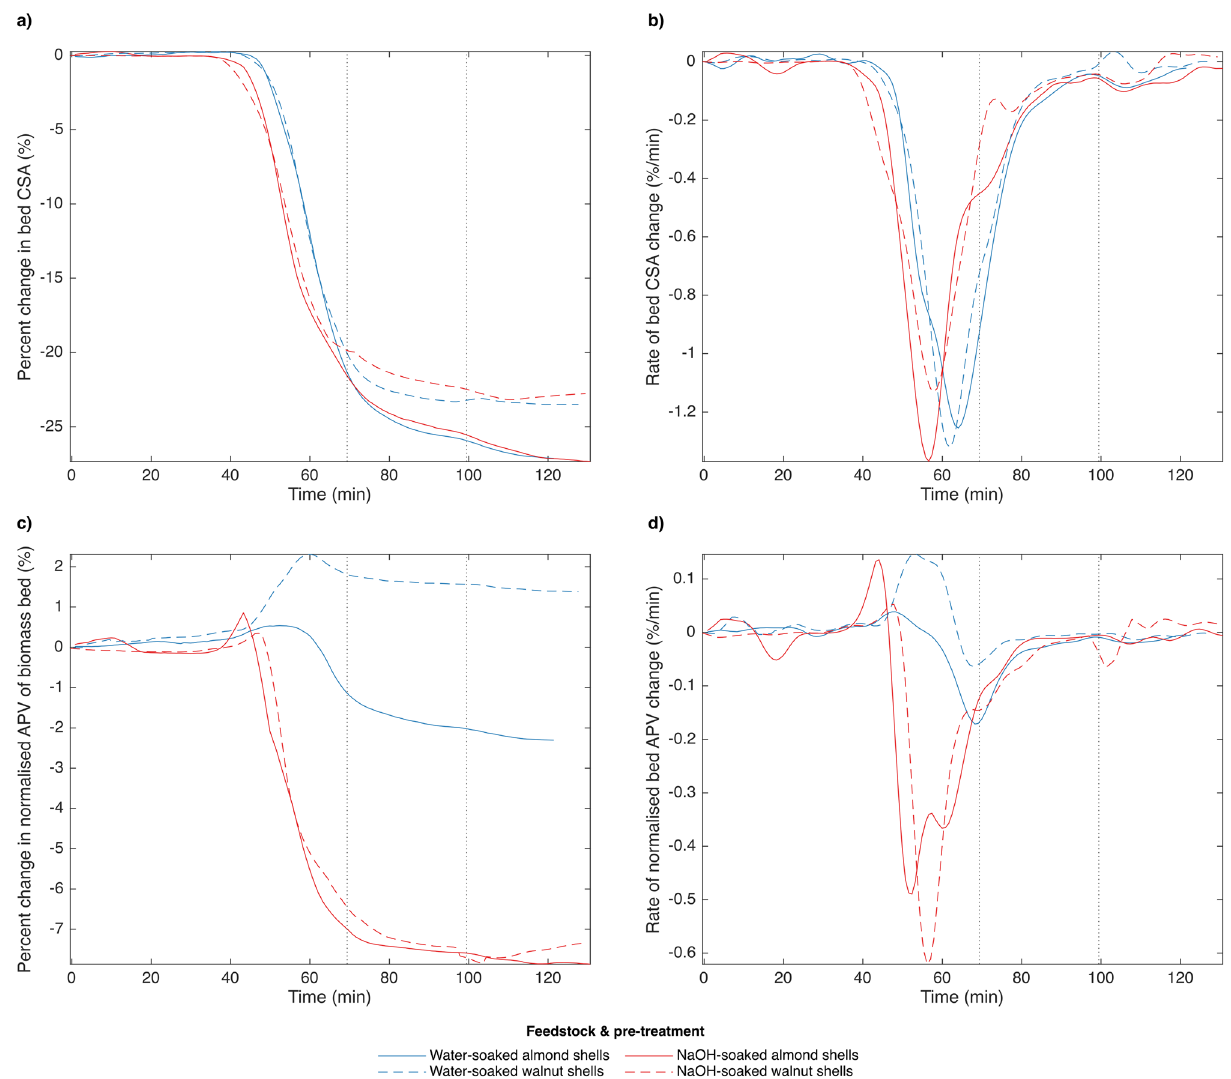
by that of the cell void space. Samples were pyrolysed by a 3 L min −1 stream of pre-heated argon at a rate of 6 °C min −1 , followed by a 30-min hold time at peak temperature. Vertical lines indicate the start and end of the 30-min hold time (450 °C for all samples). ( a ) CSA. ( b ) d(CSA)/dt. ( c ) APV. ( d )